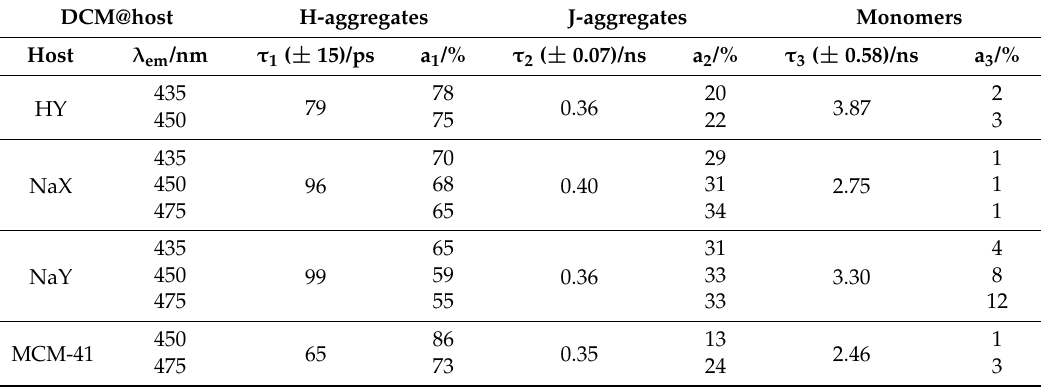
Table 3. Values of time constants ( τ i ) and normalized (to 100) pre-exponential factors (a i ) obtained from the fit of the emission decays of DCM interacting with HY, NaX, NaY, and MCM-41 prepared from the Table. The estimated uncertainty of the time constants, considering the errors from the